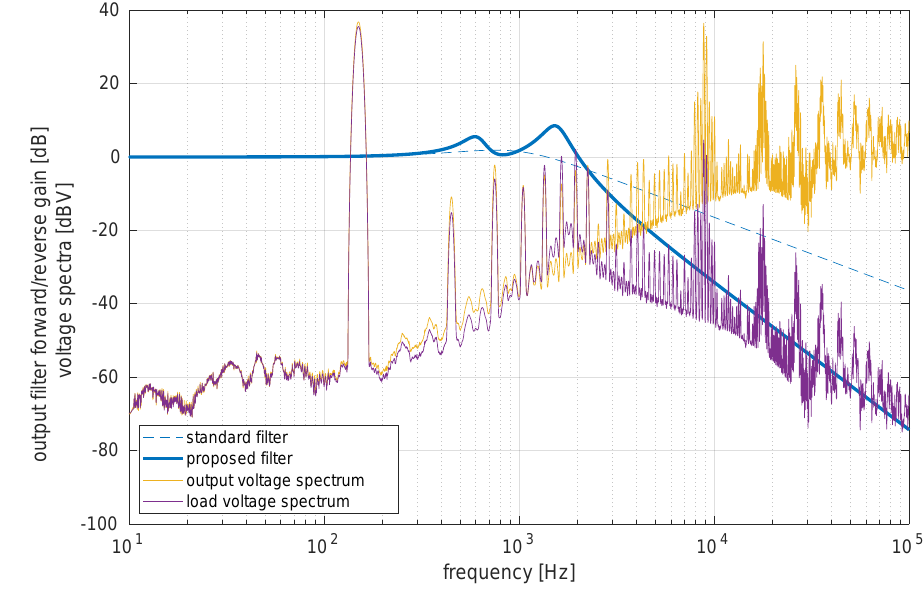
Figure 10. Spectra of the source current and load voltage obtained by SVM.